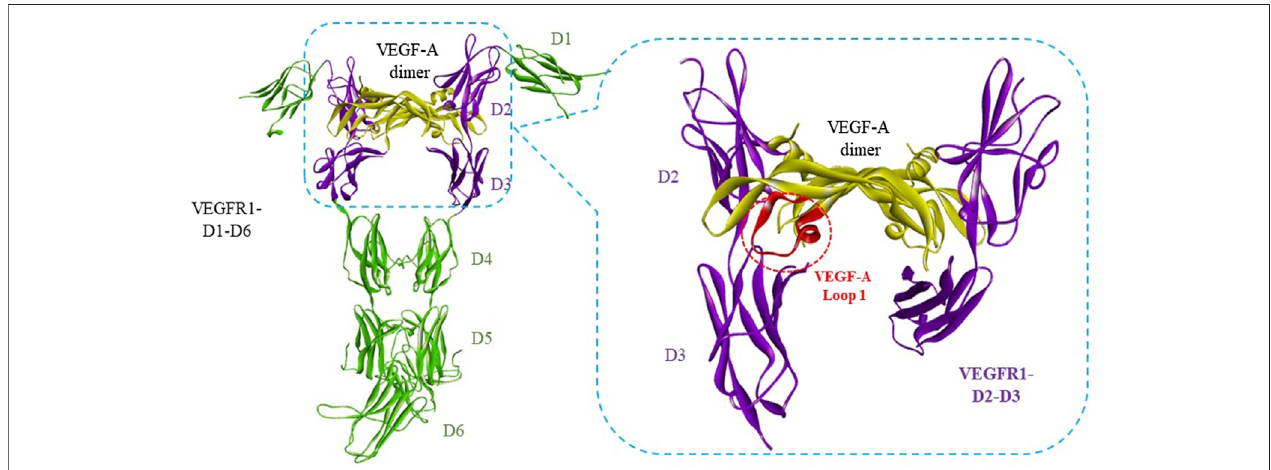
FIGURE 1 | Interaction between VEGF-A with VEGFR1 D1 to D6. The complex structure of VEGF-A dimer with VEGFR1-D1-D6 was adopted from PDB 5T89 (Markovic-Mueller et al., 2017). The VEGF-A/VEGFR binding regions were framed in blue dash lines. Loop 1 of VEGF-A, circled in red dash lines, binds mainly to VEGFR1-D3.